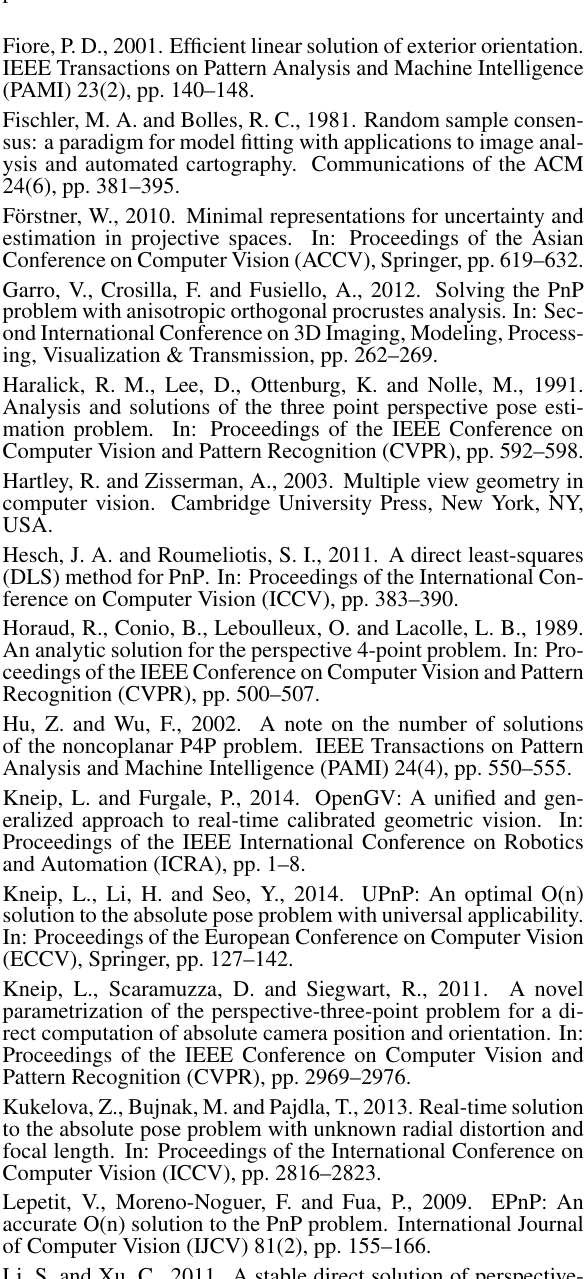
Figure 5. (a) mean orientation and (b) mean translation standard deviation over all frames of the real trajectory. (c) mean runtime over all frames. CEPPnP and MLPnP+ Σ incorporate measurement uncertainty. All other algorithms assume equally well measured image